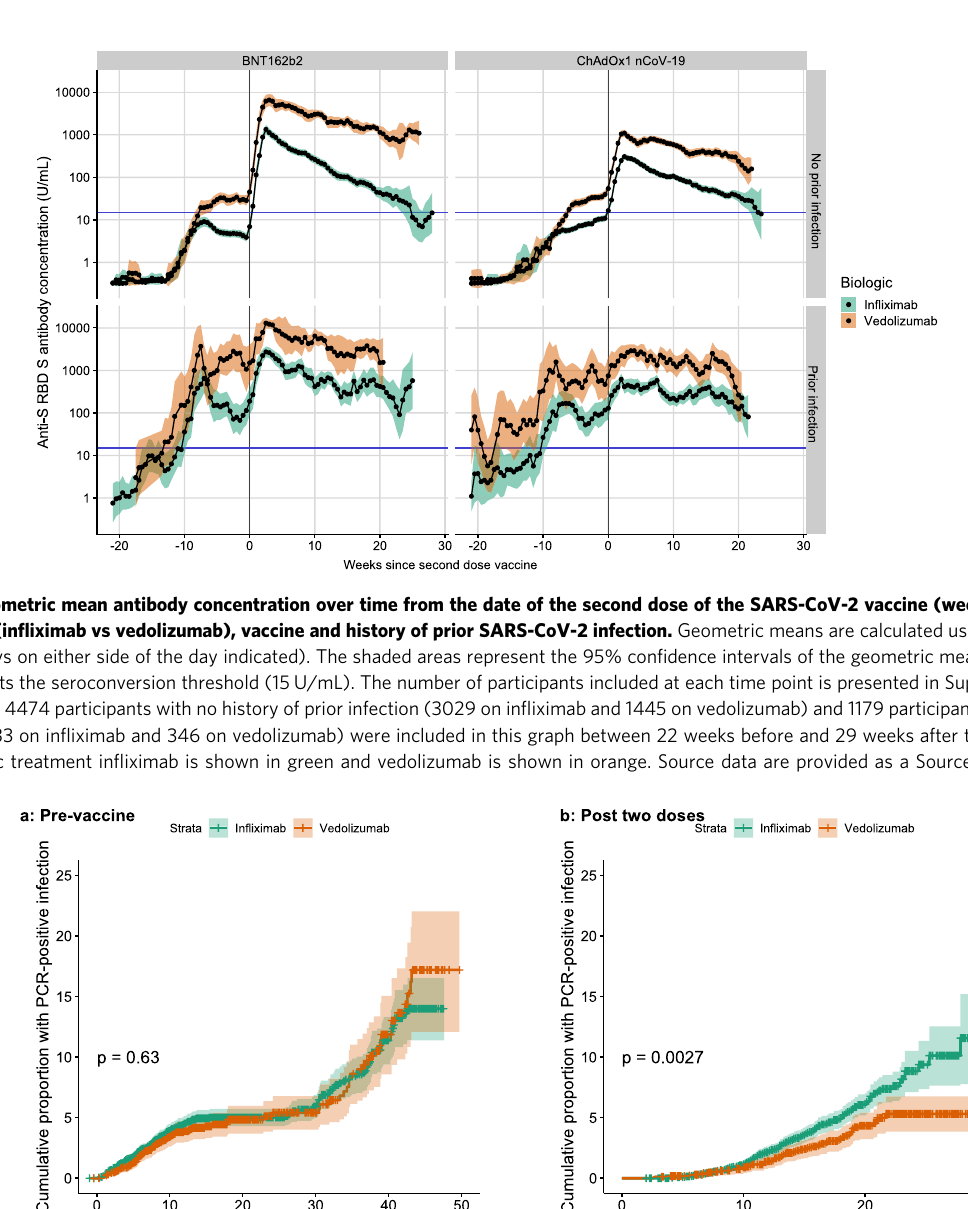
eliciting high-prevalence CD4 responses covering diverse HLA-II haplotypes 28,32 . Use of this spike MEP in otherwise healthy SARS-CoV-2 seropositive individuals elicits a T cell response in 83% of individuals at 16 – 18 weeks after natural SARS- CoV-2 infection and 91% of healthy individuals 2 – 3 weeks after two-dose vacci- nation with seronegative individuals showing a level of response indistinguishable from pre-pandemic controls 28,32 . Plates were cultured for 18 – 20 h before